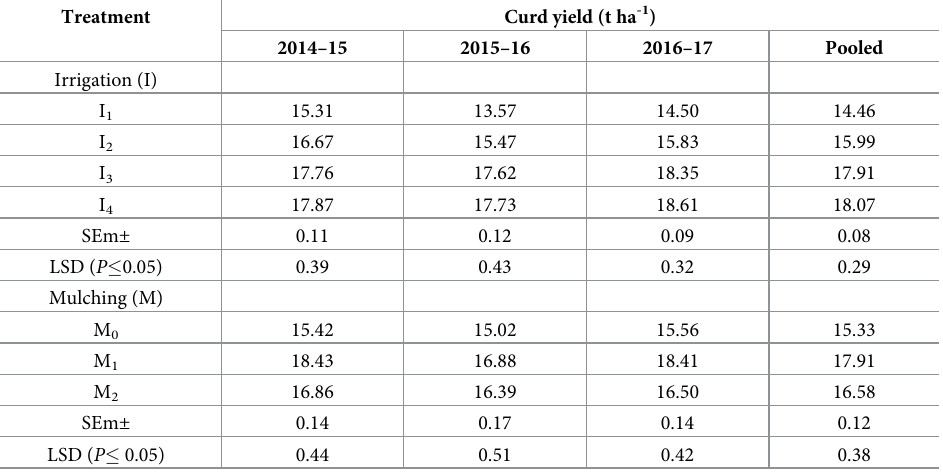
Table 2. Effects of different methods and levels of irrigation and mulches on broccoli curd yield.